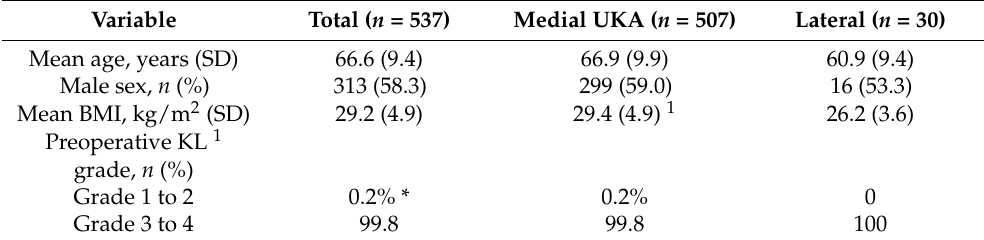
Table 1. Preoperative characteristics of the